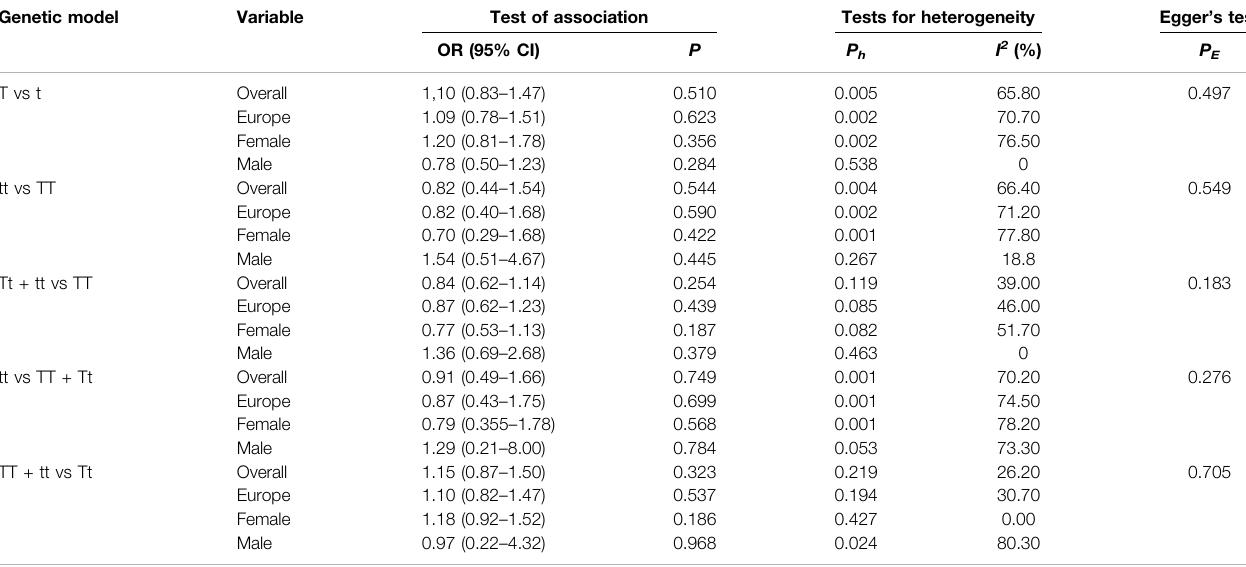
TABLE 9 | Pooled estimates of association of VDR TaqI polymorphism and the risk of osteoporotic fracture. Genetic model